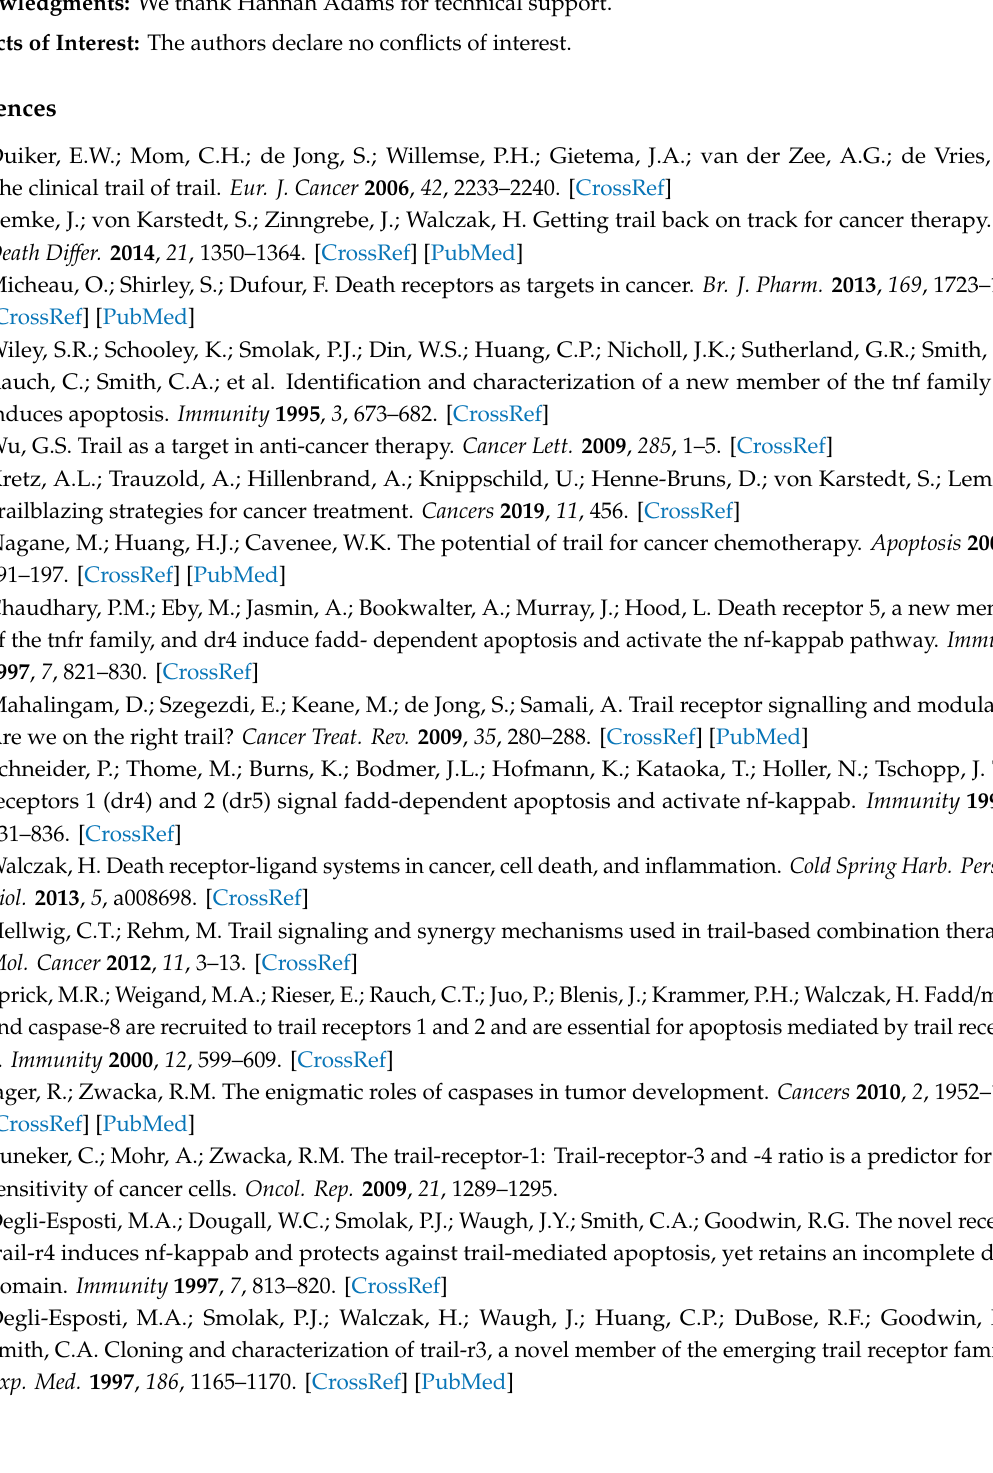
Figure S1: TRAIL-receptor expression, AKT phosphorylation and triple treatments, Figure S2: Cytokine Array indicating the order of cytokines on the